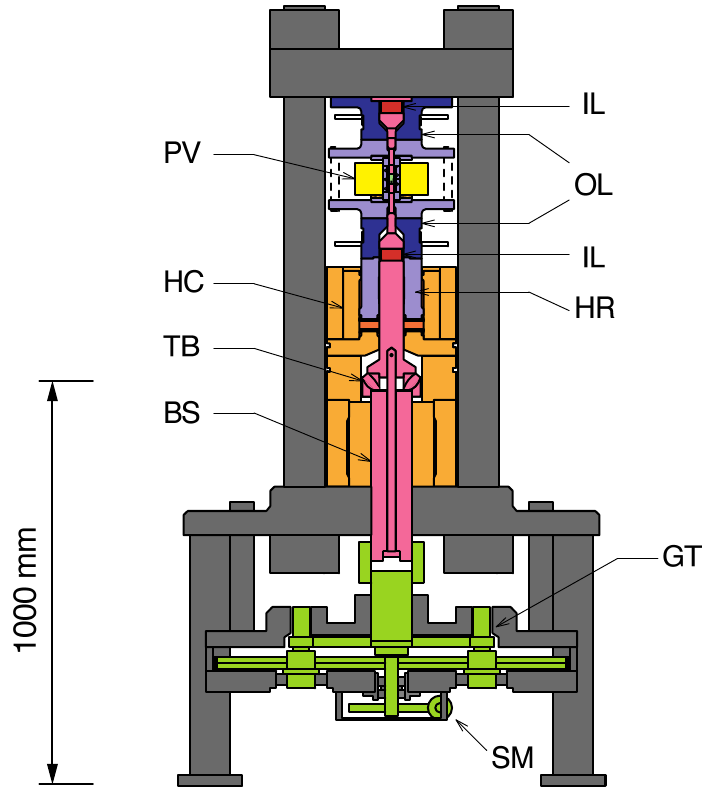
Figure 2. Solid-medium deformation apparatus designed by M. Kumazawa. PV, pressure vessel; HR, hydraulic ram; HC, hydraulic cylinder; TB, thrust bearing; BS, ball screw; GT, gear train; SM, stepping motor; IL, inner load cell for axial force; OL, outer load